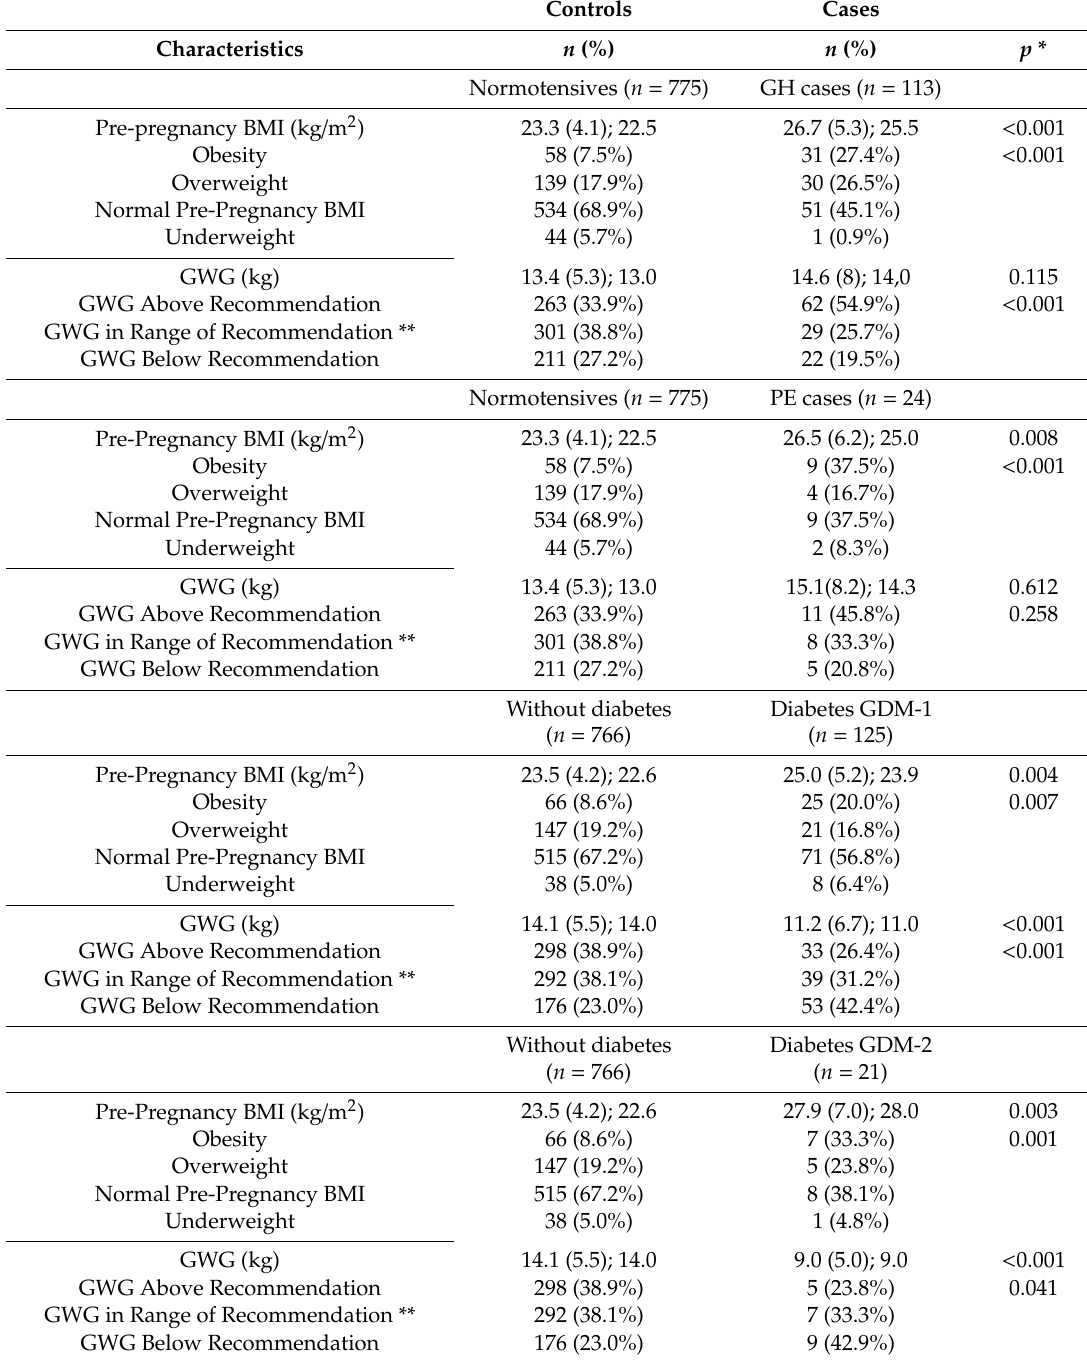
Table 2. Characteristics of pre-pregnancy BMI and gestational weight gain in the mothers with hypertension or diabetes in